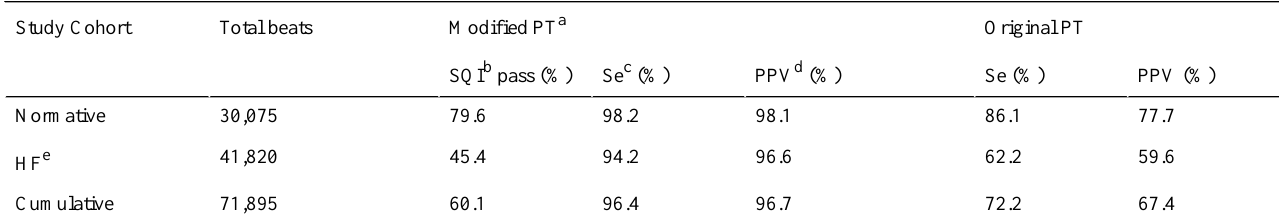
Table 2. Buttocks electrocardiogram beat classification results comparing the original and modified Pan–Tompkins algorithm.